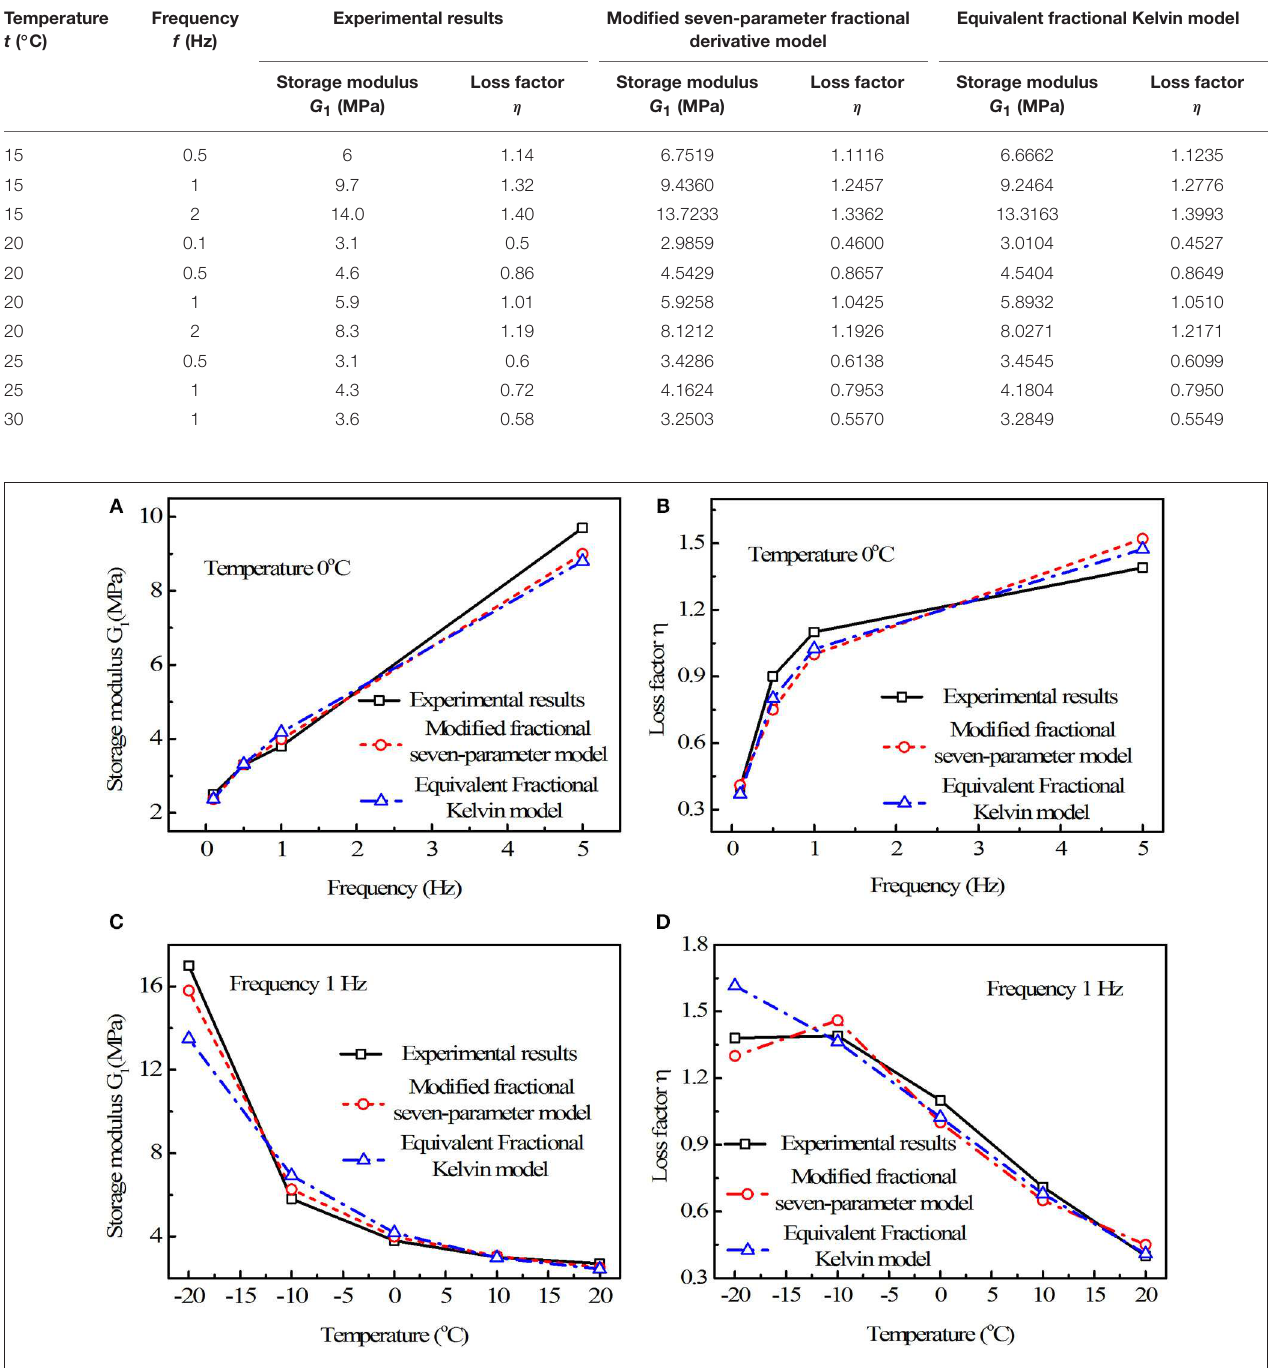
FIGURE 8 | The experimental and numerical results comparison of 9050A viscoelastic material. (A–D) Storage modulus, loss factor, storage modulus, and loss factor, respectively.